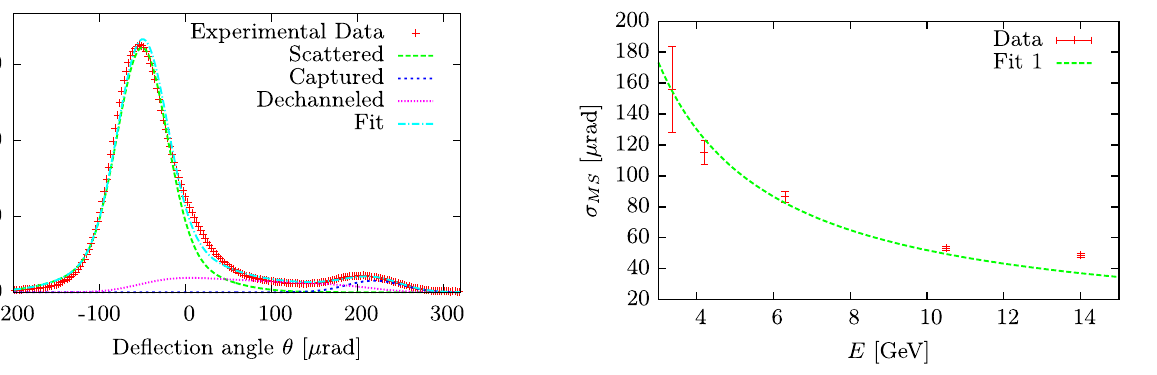
FIG. 15. The width of the channeling peak in the direction parallel to the plane is fitted to obtain Eq. (16).